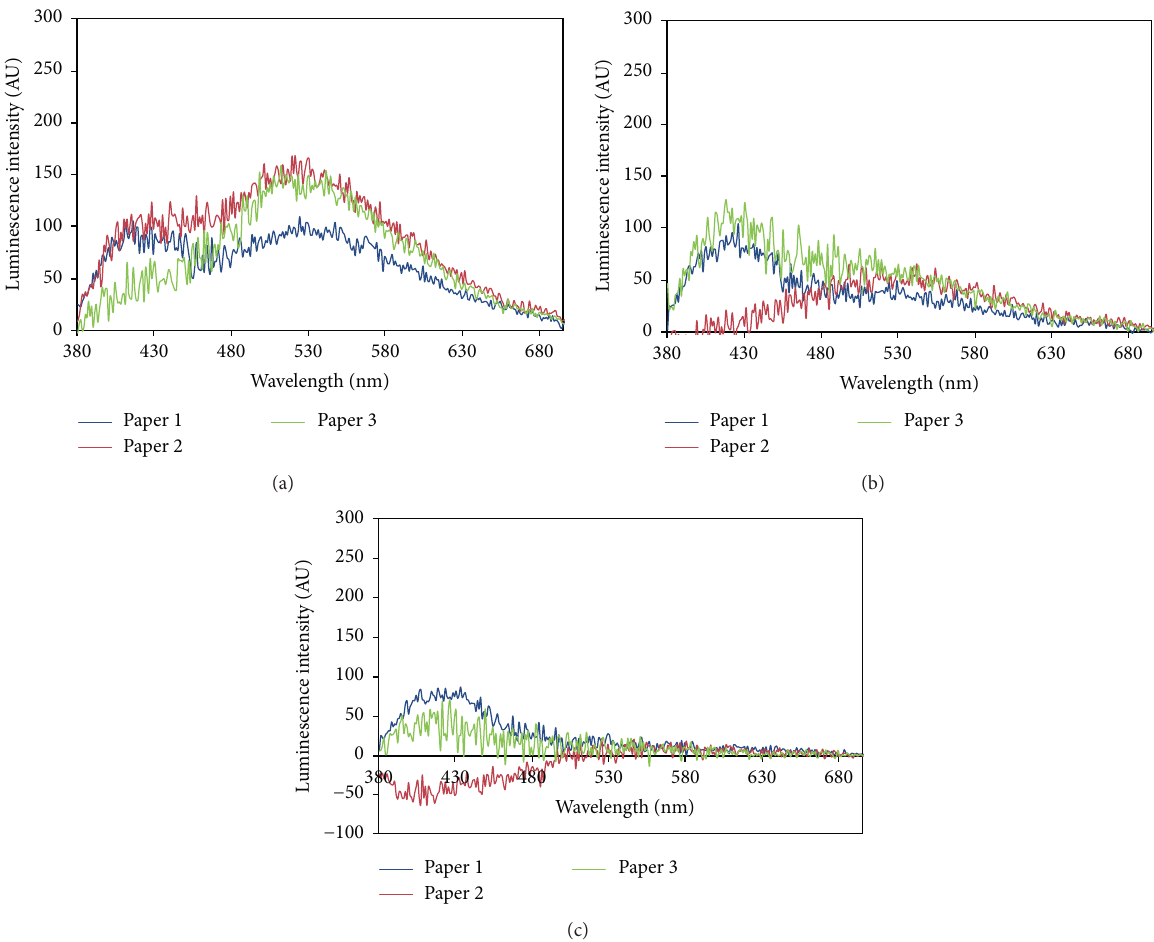
Figure 13: The luminescence spectra of images printed onto the papers with different content of OBAs using the ink compositions with the following contents of the fluorescent component (ZnO nanoparticles): (a) 0.15%; (b) 0.1%; (c) 0.05%; ink layer thickness: (a) 18.0 ± 1.0 𝜇 m, (b) 18.0 ± 1.0 𝜇 m, and (c) 16.0 ± 0.5 𝜇